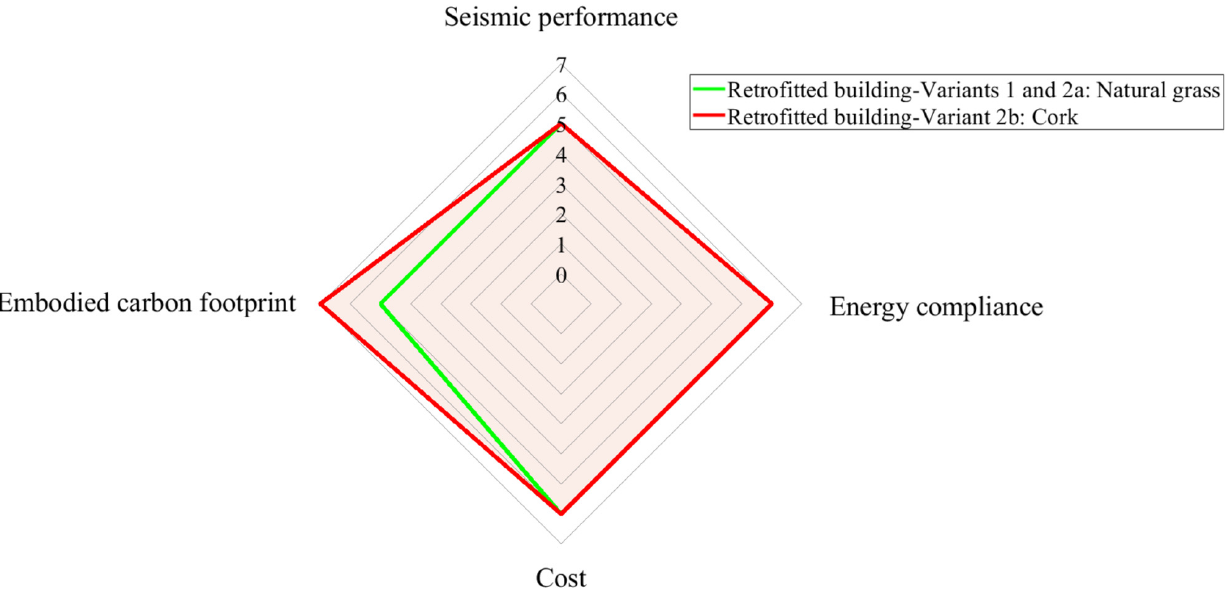
retrofitted building. rofitted building.